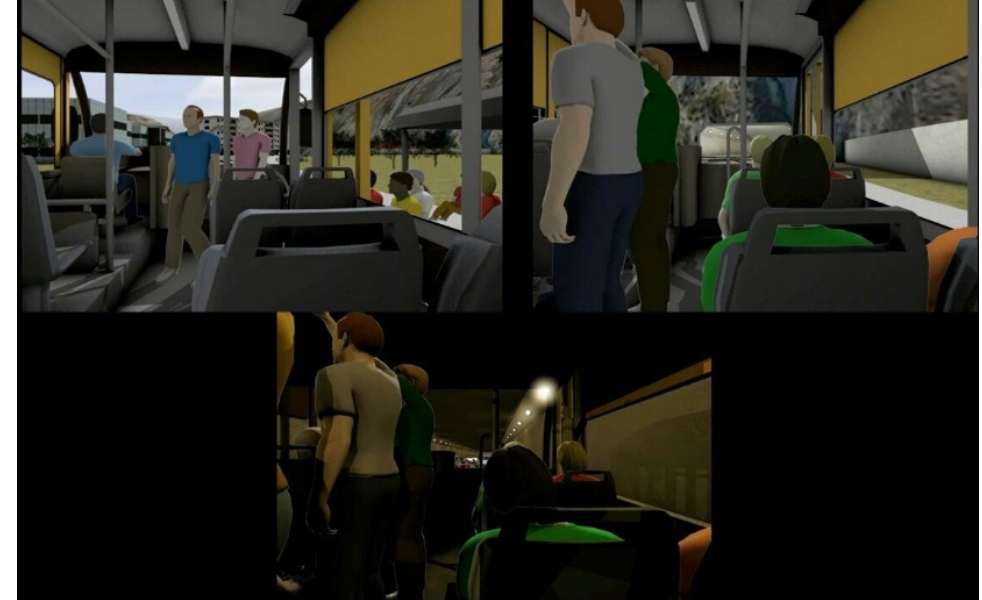
Figure 3. Illustration of the computer simulation. The subjects were instructed to look at the center of the screen at all times. The animation was in a first-person perspective, and camera movement occurred as if the subject was walking and looking in different directions. The computer simulation for triggering anxiety is cognition-mediated technique that bridges still images and virtual reality. In the context, images are easy to manage and can be anxiogenic/panicogenic. On the other hand, it can be tailored to the patient’s needs, is interactive, induces meaningful sense of presence, and can to compare the effects of virtual reality sessions.